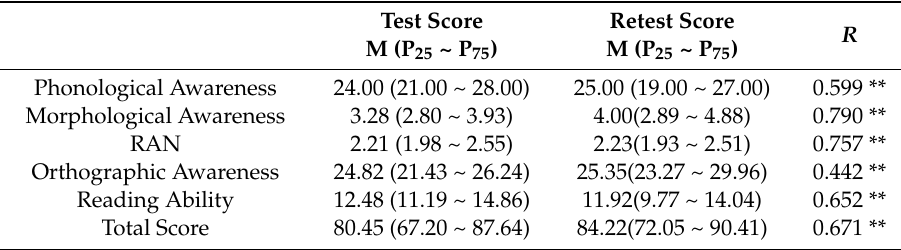
Table 1. Test–retest reliability of each subscale and total score.